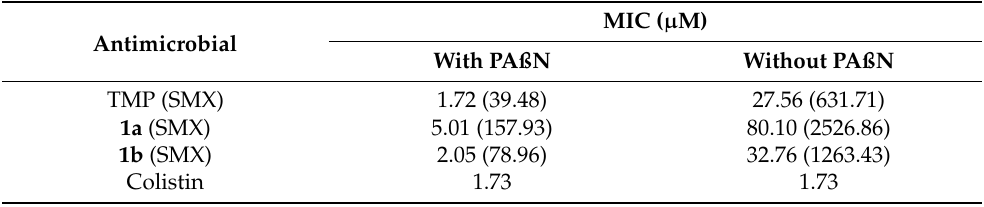
Table 5. MIC values of TMP and compounds 1a and 1b in combination with SMX (1:20) as well as colistin in P. aeruginosa PAO1 in the presence or absence of the efflux pump inhibitor PAßN (20 µ g/mL).